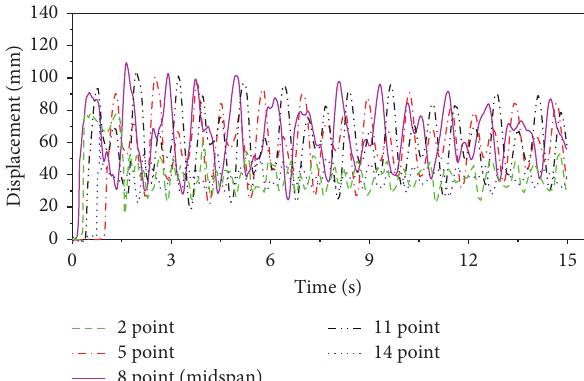
Figure 6: Displacement-time history curve of the midpoint of ice-shedding area under different ice-shedding positions (X ∼ XIV).